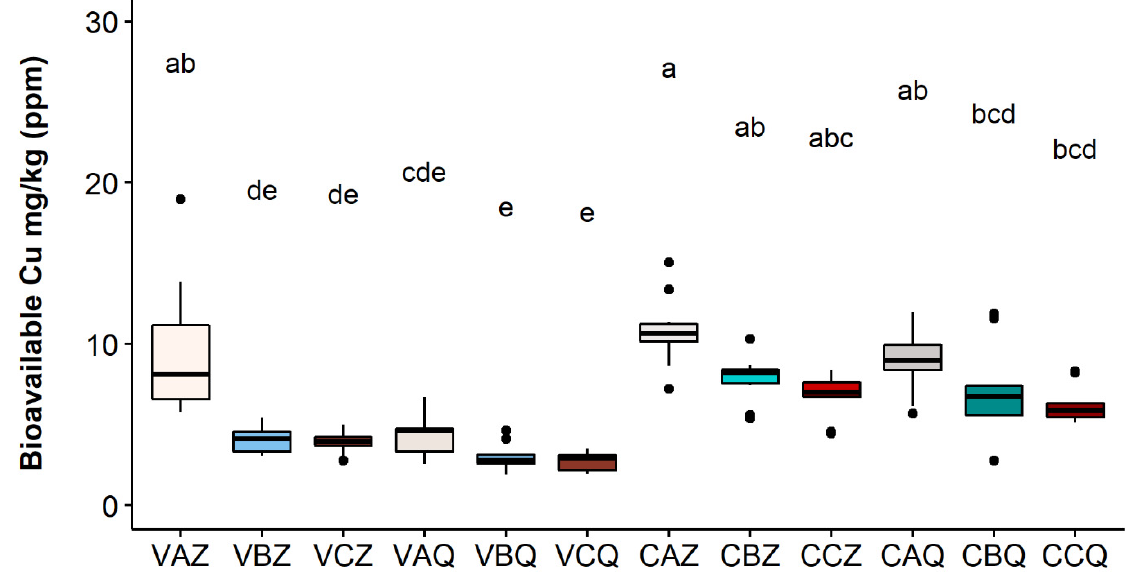
Figure 4. Bioavailable Cu concentration in each sample in 2020. Lower case letters refer to Dunn’s multiple comparisons (Benjamini–Hochberg p -value adjustment, α -level = 0.05). Code legend: the first letter refers to the vineyard; (C) Castelplanio, (V) Varano. The second letter refers to the thesis: (A) Cu treatments, (B) Alternate treatments with Cu and chitosan, and (C) Chitosan treatments. The third letter refers to the depth: (Z) 0–20 cm, (Q) 20–40